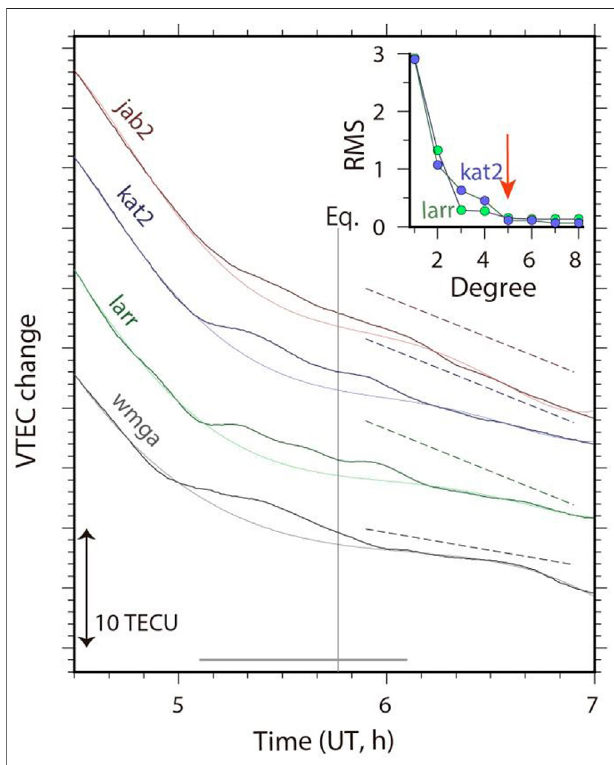
FIGURE 3 | The same VTEC time series as Figures 2A – 1 , but constant trends (attached to each curve as a dashed line) are removed from individual time series for visual clarity of the positive anomalies. The exclusion window is given at the bottom as a horizontal gray line. From the inset showing the behavior of RMS of post- fi t residuals (calculated outside the exclusion window) for different polynomial degrees, weconsidered degree fi ve the most